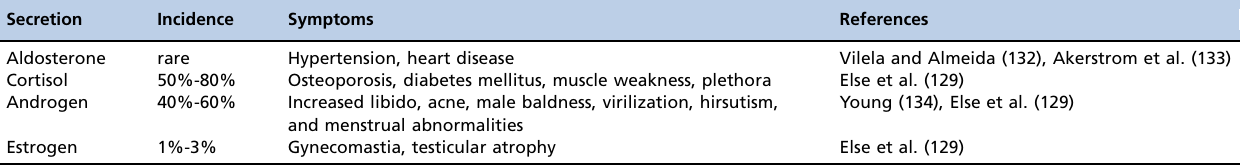
Table 1 - Endocrine features of functional